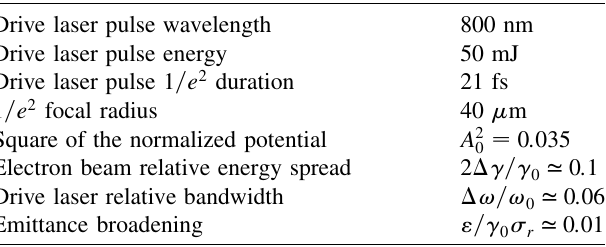
TABLE II. X-ray code